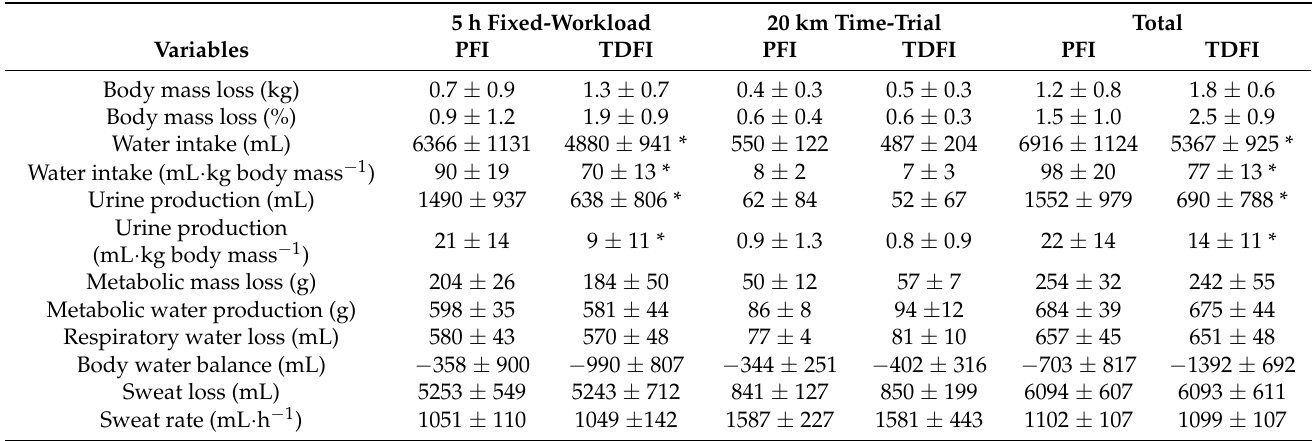
Table 2. Fluid balance data during the 5 h fixed-workload exercise period and the 20 km time-trial for the programmed (PFI) and thirst-driven fluid intake (TDFI) strategies.